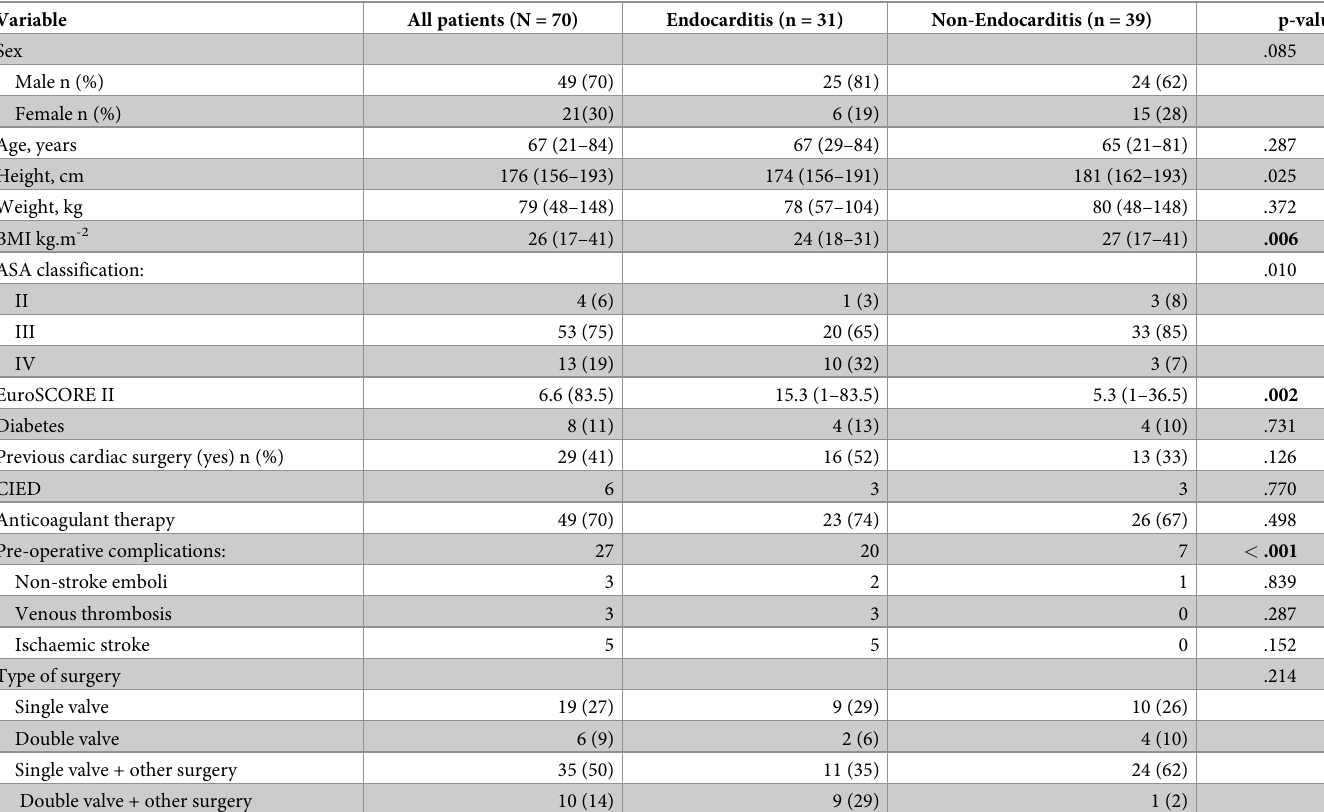
Table 1. Characteristics of patients with and without infective endocarditis.